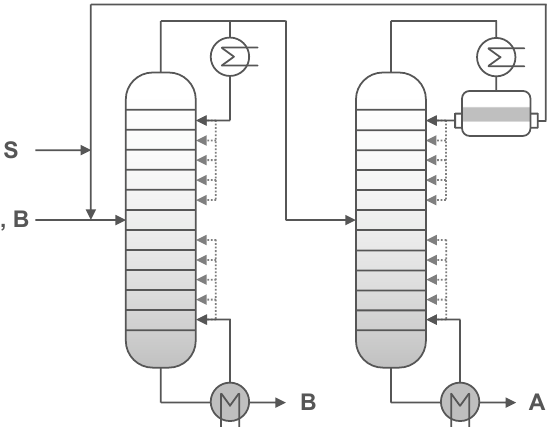
Figure 1. Superstructure for the optimization of a heteroazeotropic distillation